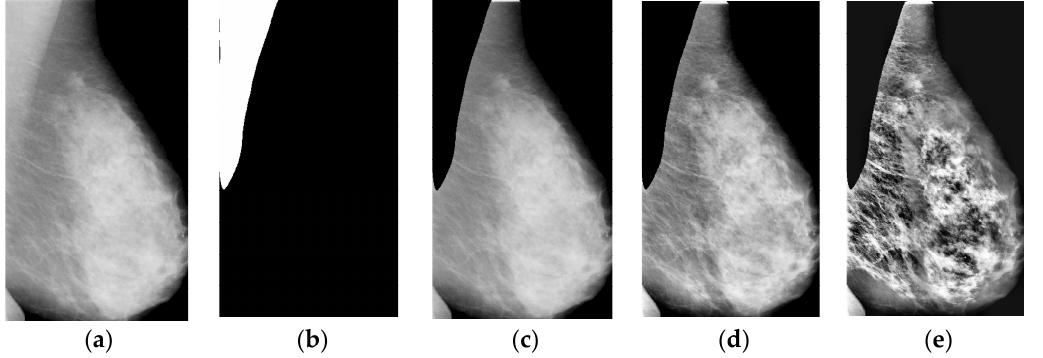
Figure 1. Pre-processing examples. ( a ) Breast-only image. We automatically extract the breast from a mammogram as we are only interested in the breast region. ( b ) Pectoral segmentation result. ( c ) Pectoral-muscle-removed breast image. Deeplab3+ model is trained for pectoral muscle segmenta- tion. ( d ) Breast image enhanced by CLAHE when λ is 0.05. ( e ) Breast image enhanced by CLAHE when λ is